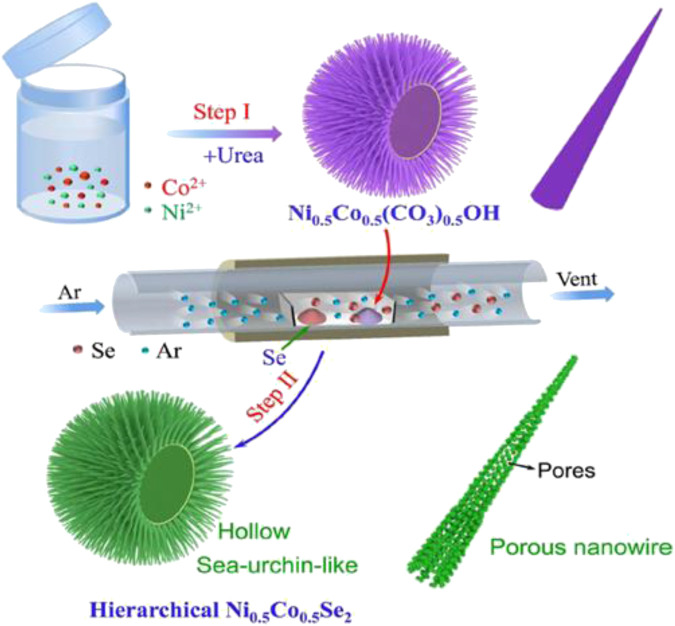
Hierarchical hollow, sea-urchin-like and porous Ni0.5Co0.5Se2 as advanced battery.